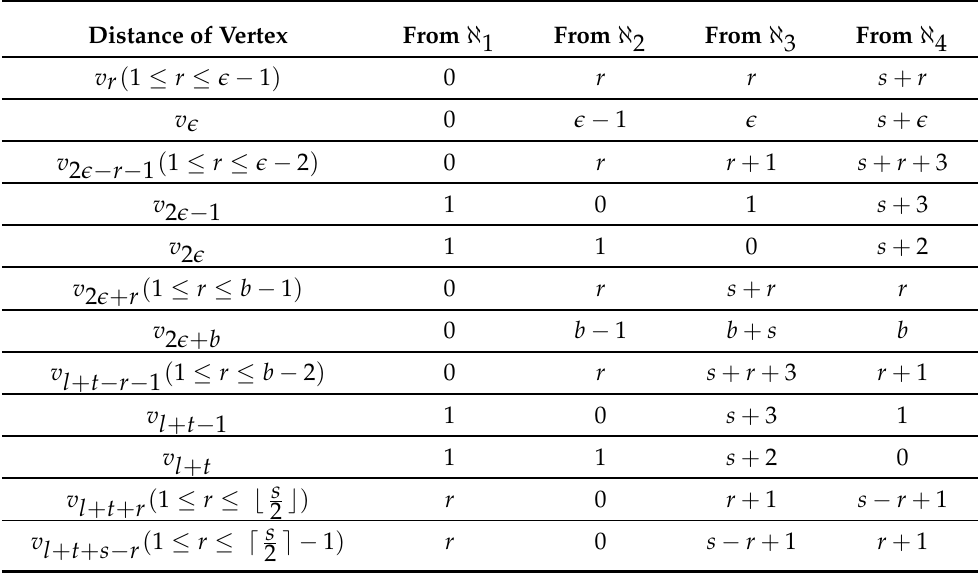
Table 1. Distance codes of V ( KP ( l , t , s )) with respect to ℵ for l = 2 (cid:101) , where (cid:101) ≥ 2, and t = 2 b , where b ≥ 2. Distance of Vertex